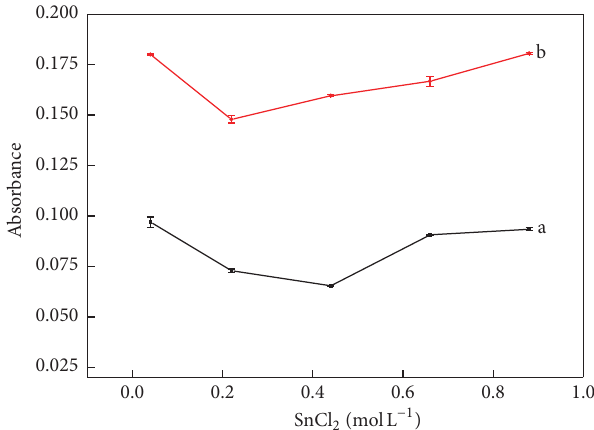
Figure 2: Effect of the concentration of the reducing agent. Curves a and b correspond to the blank and a 150 𝜇 gL −1 Mo (VI) standard solution, respectively. Experimental conditions: 0.5 mol L −1 SCN − ; seven sampling cycles; time intervals to insert sample and SCN − solution 2.0 and 1.0s, respectively; pumping rate at 50 𝜇 Ls −1 .